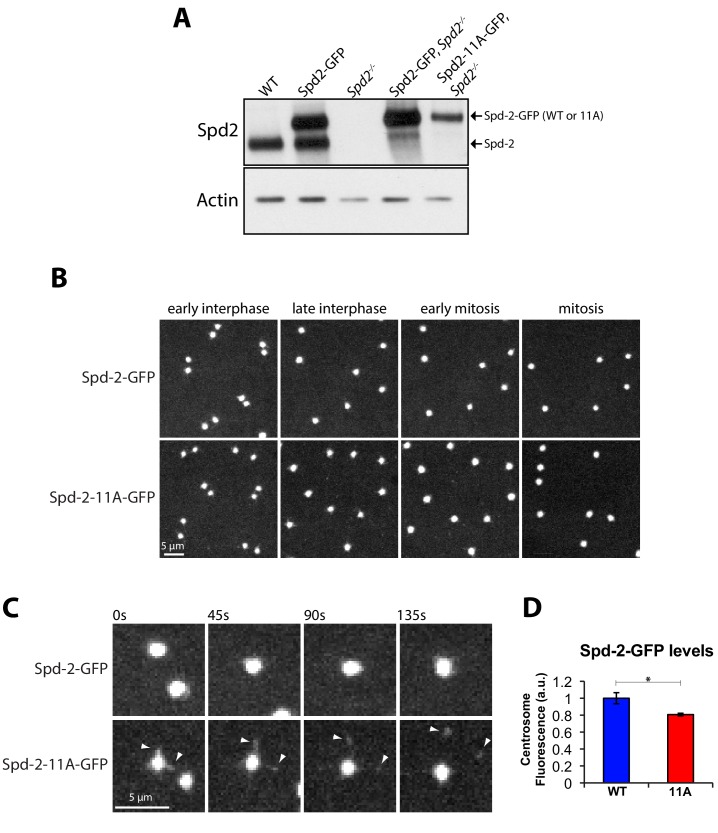
Mutation of several centrosomal phosphosites in Spd-2 appears to have only a small effect on the centrosomal function of Spd-2 in vivo.(A) Western blot analysis of WT or Spd-2 mutant larval brain cells expressing either Spd-2-GFP or Spd-2-11A-GFP (as indicated). (B) Micrographs show stills of living Spd-2 mutant embryos expressing either Spd-2-GFP or Spd-2-11A-GFP, imaged on a spinning disk confocal microscope. Both constructs efficiently rescue the Spd2 mutant embryos (data not shown), which normally do not develop due to a failure in pronuclear fusion (Dix and Raff, 2007). (C) Micrographs show a magnified view of centrosomes, highlighting that although WT Spd-2-GFP and Spd-2-11A-GFP are both highly concentrated at centrosomes, a small number of ‘flares’ of Spd-2-11A-GFP can be detected that are constantly being ejected from the centrosomes (arrowheads); such Spd-2 flaring can occur when the PCM matrix has been weakened (Conduit et al., 2014b). (D) Graph quantifies the centrosomal fluorescent intensity of either Spd-2-GFP or Spd-2-11A-GFP at mid-late S-phase in Spd-2 mutant embryos (in arbitrary fluorescence units [a.u.], WT normalised to 1). 10 centrosomes per embryo were analysed; n = 5 embryos for each condition. Bars represent mean ± SEM. The Shapiro-Wilk normality test was used to check Gaussian distribution of the data. The difference between the two datasets was determined to be statistically significant using the unpaired t test with Welch’s correction (*, p<0.05).10.7554/eLife.50130.005Figure 1—figure supplement 1—source data 1.Figure 1—figure supplement 1D source data, quantification of centrosomal fluorescent intensity of either Spd-2-GFP or Spd-2-11A-GFP.